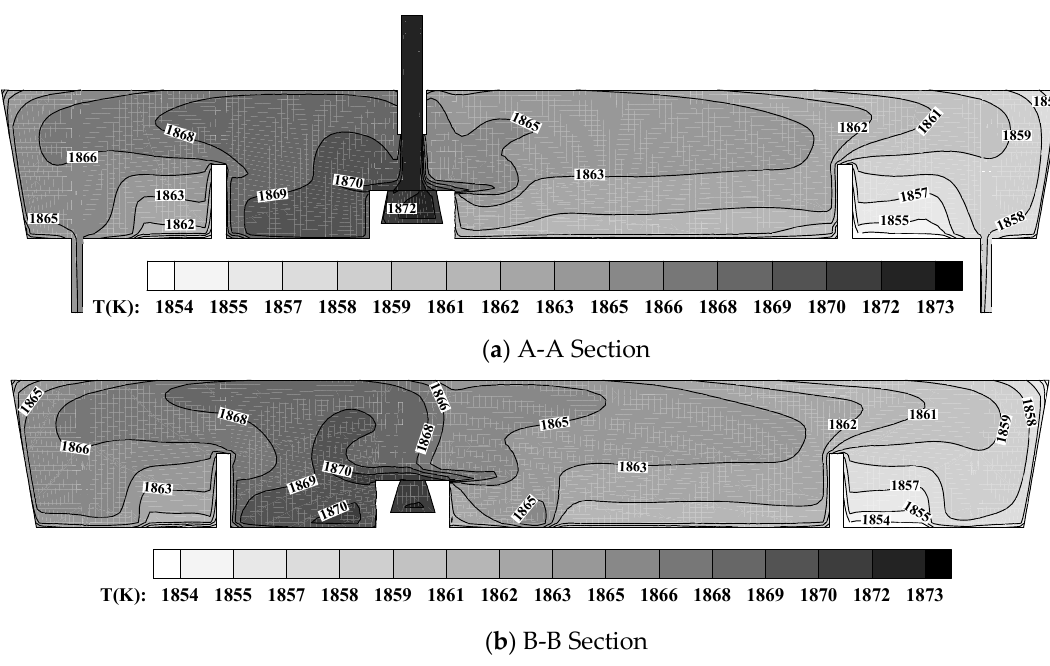
Figure 8. Temperature field in the original tundish.